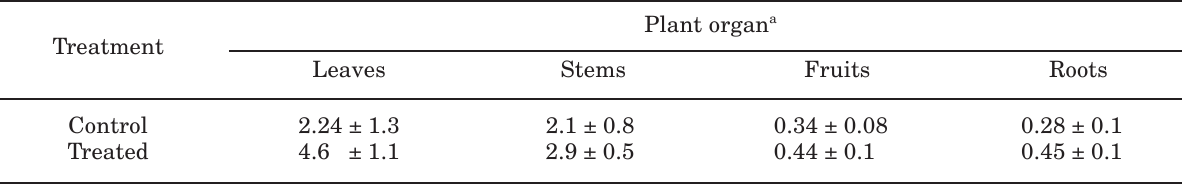
Table 4. Total polyphenols (gallic acid g/100 g f wt) in different organs of Vitis cv. Flame treated with Brotomax. The analysis was carried out in the first week of